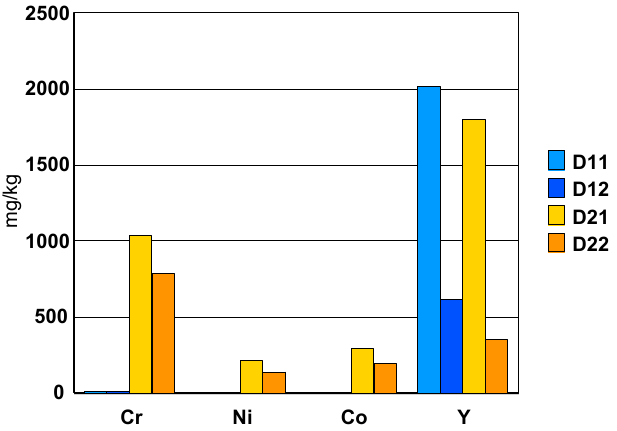
Figure 10. Concentrations of Cr, Ni, Co and Y [ mg/kg ] found in solution.